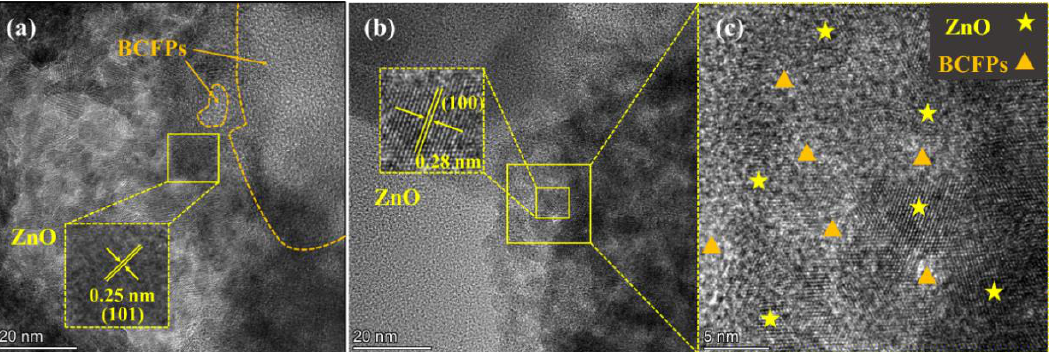
Figure 5. HRTEM images of particle electrode: ( a − c ) the lattice fringes and distribution of ZnO in the BCFPs.